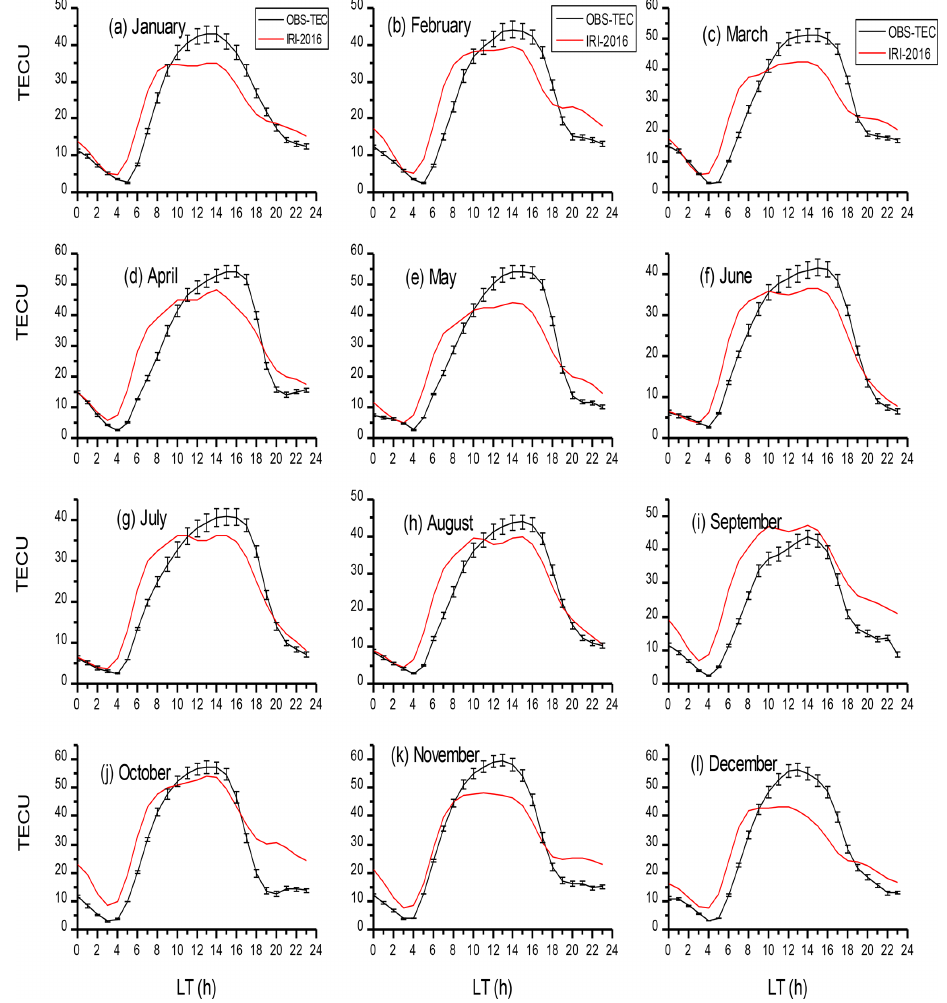
Figure 3. Same as Fig. 1 but for